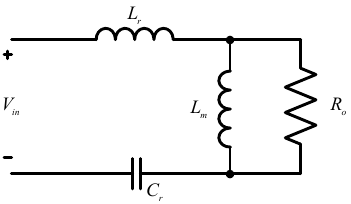
Figure 4. Primary-side equivalent model of LLC resonant converter.